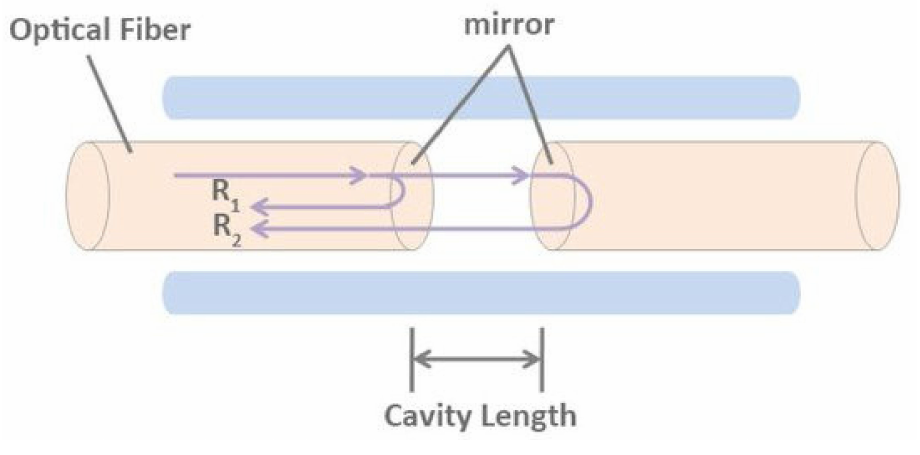
Figure 8. Fabry-Perot FOS